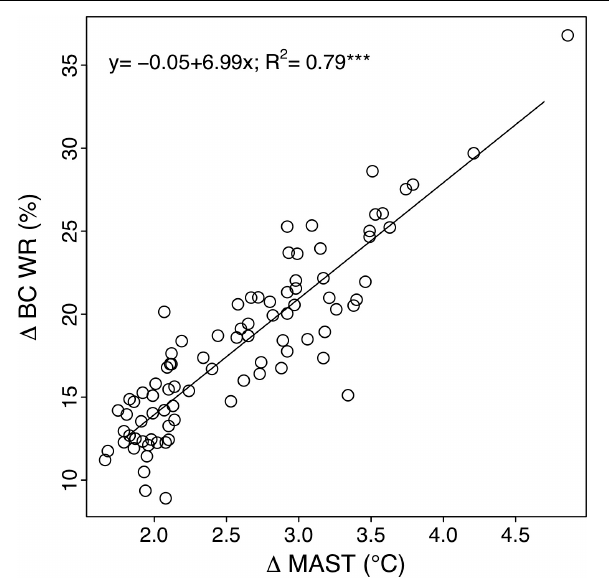
FIGURE 7 | Relationship between changes in base cations weathering rate ( (cid:49) BC WR; %) and changes in mean annual soil temperature ( (cid:49) MAST; ◦ C). Values are derived from PROFILE projections from the 2041–2070 and 2071–2100 periods. The line is the linear regression ( P <